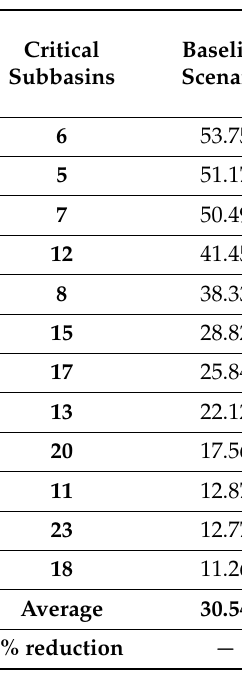
Table 11. Summary of developed scenarios result for twelve critical